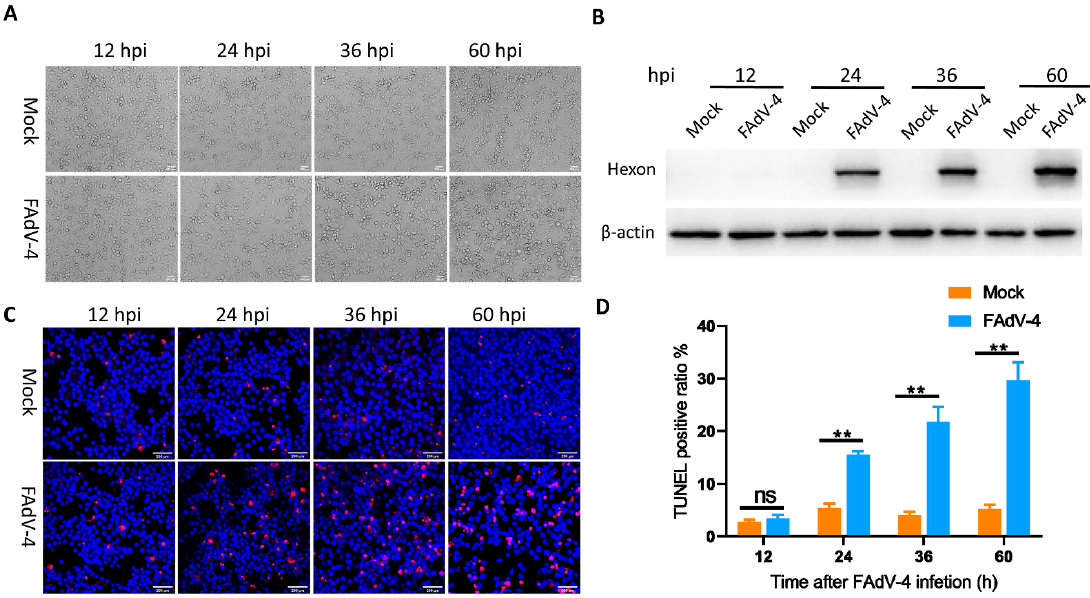
Figure 1. FAdV-4 replicated and induced apoptosis in LMH Cells. ( A ) Morphological changes in LMH cells at different time points after FAdV-4 infection (MOI = 0.1), with mock-infected cells as a control. ( B ) Western blot analysis of hexon levels in FAdV-4-infected LMH cells at indicated time points post inoculation. ( C ) TUNEL labeling of FAdV-4-infected LMH cells. LMH cells were mock-infected or infected with FAdV-4 (MOI = 0.1) for 12, 24, 36 and 60 h. The cell samples were labelled with TUNEL (red) and then counterstained with Hoechst 33342(blue) solution. Scale bars, 100 μ m. ( D ) Percentage of TUNEL-positive mock-infected and FAdV-4-infected LMH cells at the indicated time points. The data represent the mean ± SD of three independent experiments. P values were calculated using Student’s t -test. An asterisk indicates a comparison with the indicated control. ** p < 0.01, n.s., not